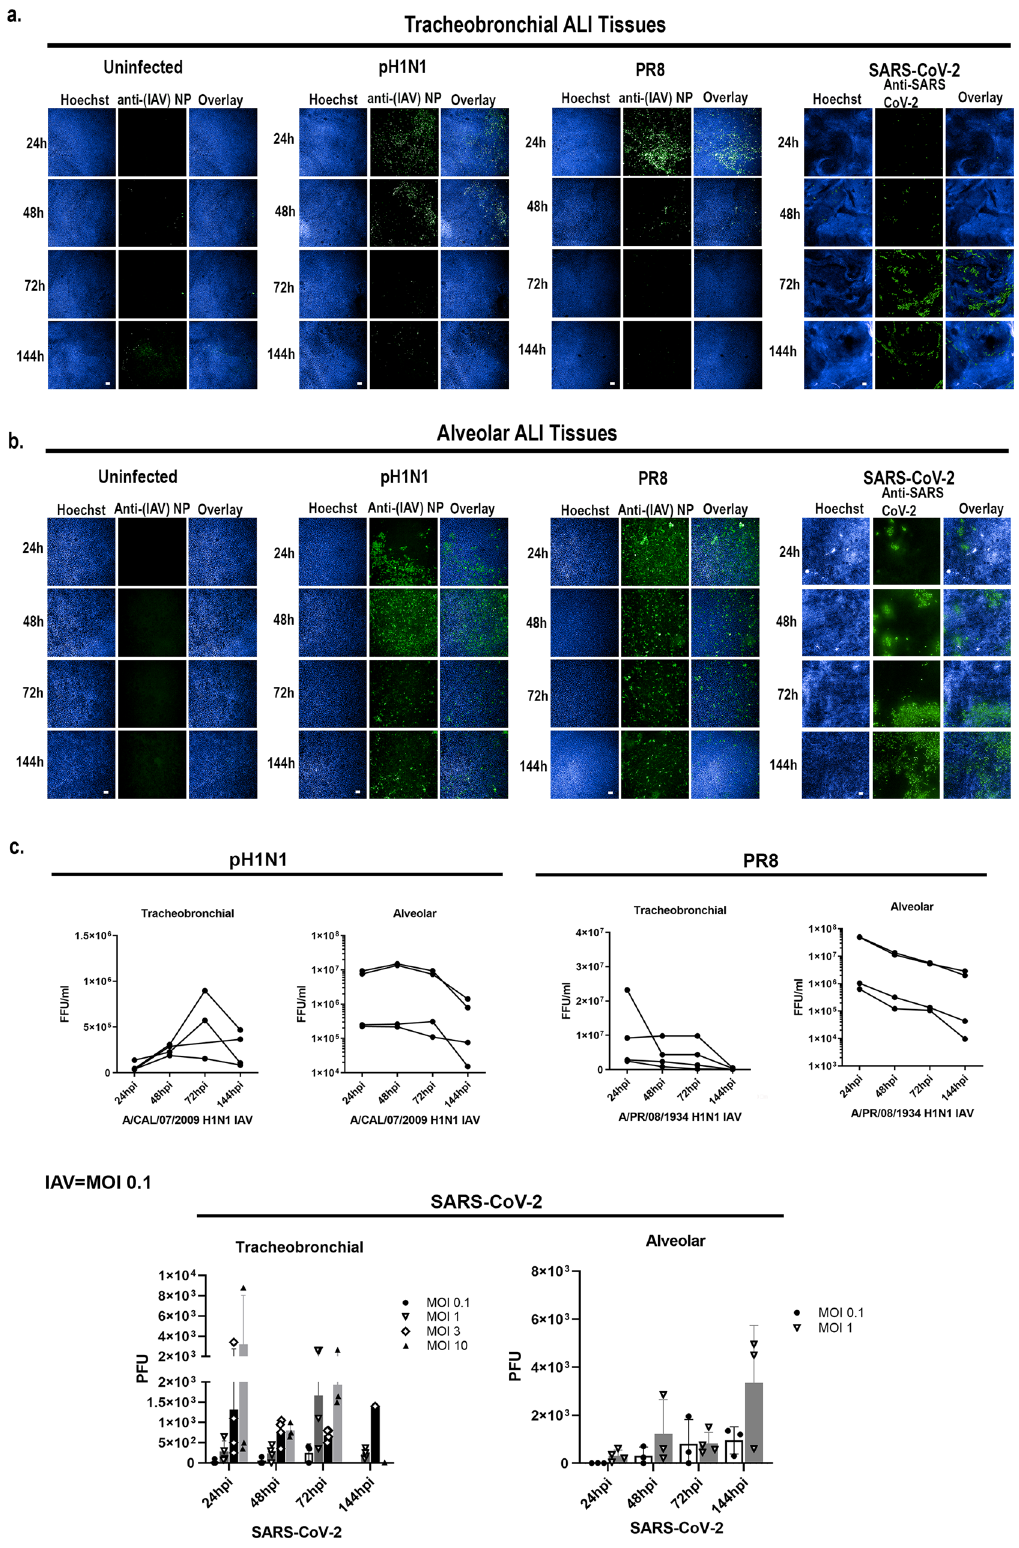
also dose-dependent, although infection with higher MOIs (3 and 10) resulted in a higher virion production at 24 hpi, followed by a decline at later time points, which may be due to cell death as a result of an initially high viral exposure (Fig. 3c). Interestingly, alveolar ALI tissues seemed to be more susceptible to IAV and SARS-CoV-2 infection than tracheobronchial ALI tissues,